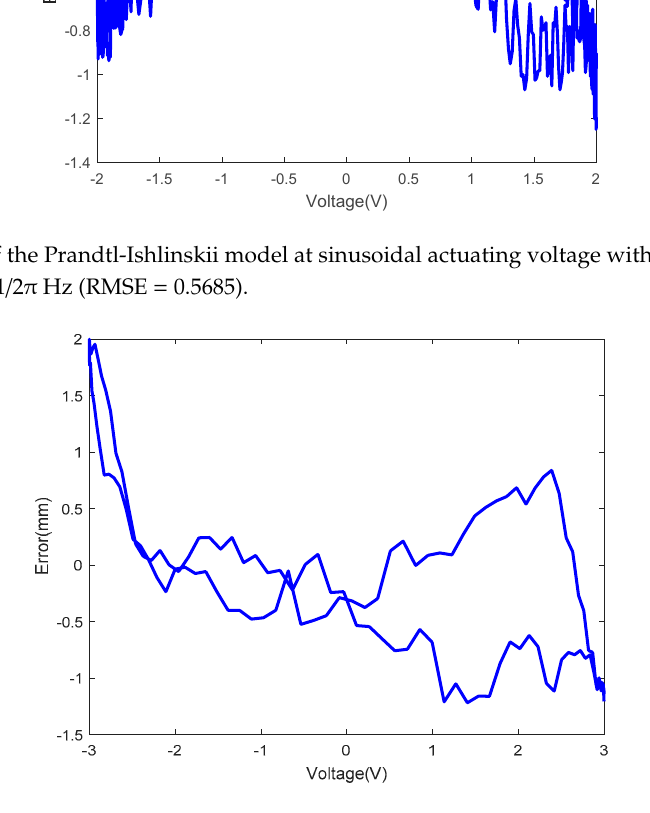
Figure 18. Error of the Prandtl ‐ Ishlinskii model at sinusoidal actuating voltage with amplitude of 3V and frequency of 5/2 π Hz (RMSE = 0.8345).